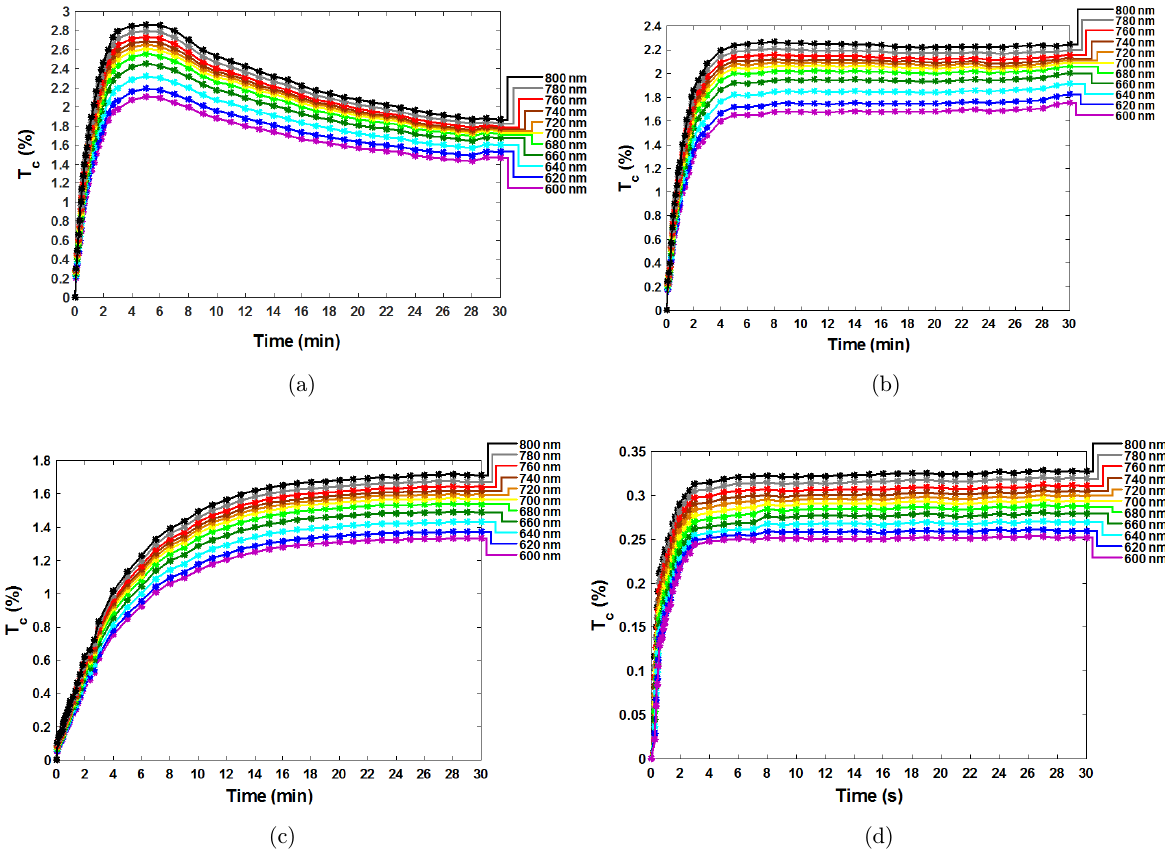
Fig. 3. Processed raw data from Ref. 23 rescaled to have T c ¼ 0 at t ¼ 0. Treatments with glucose: 20% (a), 30% (b), 40% (c) and 54%